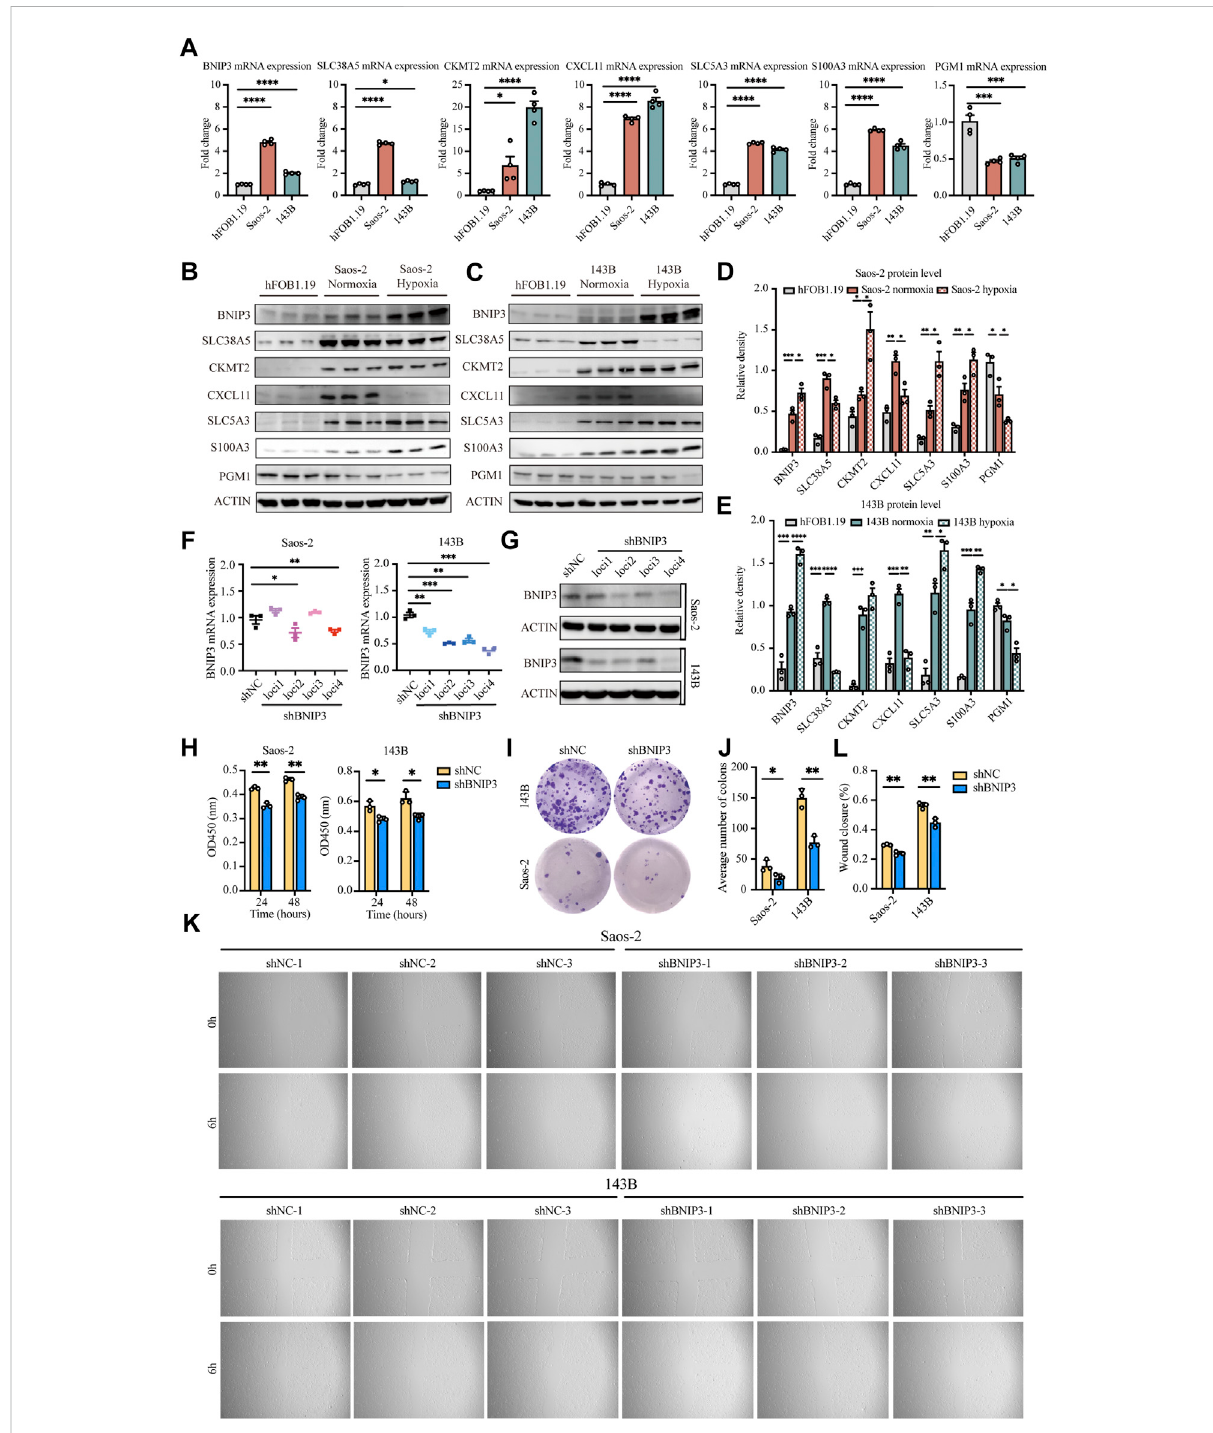
FIGURE 8 ValidationofsevensignaturegenesatmRNAandproteinlevelsandfunctionalanalysisofBNIP3 invitro . (A) RT-PCRfordetectingtheexpression of seven genes in Saos-2 and 143B osteosarcoma cells and hFOB1.19 cells. (B,D) Western blot and quanti fi cation for the expression of the seven genes in Saos-2 cells (under hypoxic or normoxic conditions) and hFOB1.19 cells. (C,E) Western blot and quanti fi cation for the expression of the sevengenesin143Bcells(underhypoxicornormoxicconditions)andhFOB1.19cells. (F) RT-PCRforverifyingtheexpressionofBNIP3inSaos-2 and 143B cells following transfection with its speci fi c shRNAs. (G) Western blot for verifying the expression of BNIP3 in Saos-2 and 143B cells following transfection withitsspeci fi cshRNAs. (H) CCK8assay ofdetecting theproliferationabilityofSaos-2and143B cellsafter BNIP3knockdown. (I,J) Colony formation for measuring the proliferation capacity of Saos-2 and 143B cells after BNIP3 knockdown. (K,L) Wound healing assay for detecting the migration ability of Saos-2 and 143B cells after BNIP3 knockdown. * p < 0.05, ** p < 0.01, *** p <